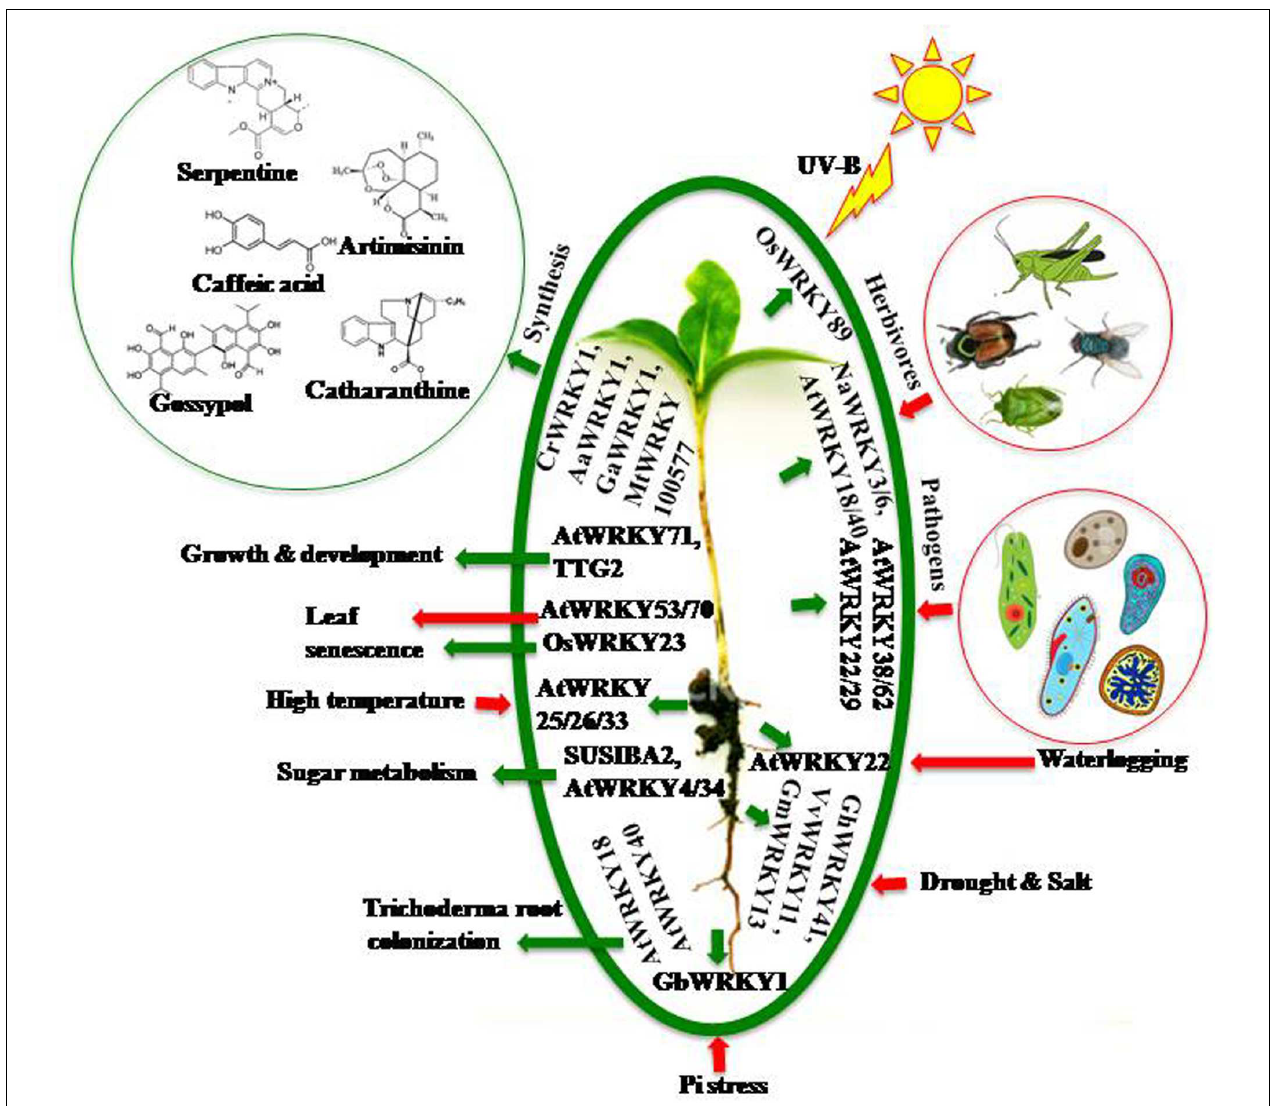
FIGURE 1 | Multiple role of WRKYs under different environmental conditions. In response to multiple stimuli plants recruit various WRKYs to regulate downstream cascade. The green arrows indicate a positive or beneficial regulation while red arrows indicate negative or harmful regulation. In response to different stresses WRKYs provide tolerance or resistance to the respective plants; like AtWRKY29, 38, 62 provide resistance to pathogen attack; AtWRKY3, 6, 18, 40 provide resistance to herbivores; OsWRKY89 protects plant from harmfull UV radiation; many WRKYs impart drought and salt tolerance; AtWRKY22 provides waterlogging tolerance; GbWRKY1 helps plant in phosphate starvation and AtWRKY25, 26 provide thermotolerance. They are also involved in metabolic and developmental responses; like CrWRKY1, AaWRKY1, GaWRKY1 are involved in secondary metabolism; AtWRKY71, TTG2 are involved in growth and development; SUSIBA2, AtWRKY34 are involved in sugar metabolism and AtWRKY18, 40 are involved in trichoderma colonization. AtWRKY53, 70 induce leaf senescence while OsWRKY23 prevents